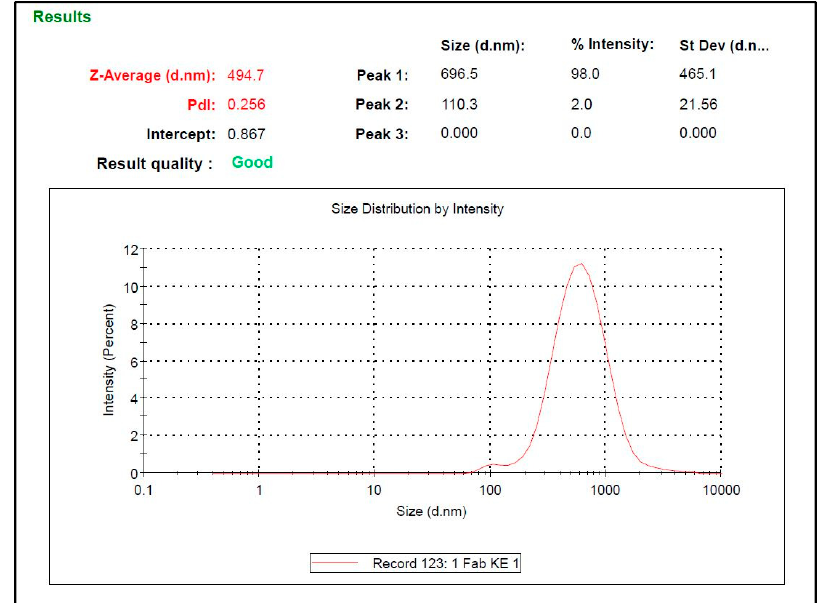
Figure 16. Particle size distribution by intensity of WS 2 particles synthesized using commercial WO 3 powder as precursor.